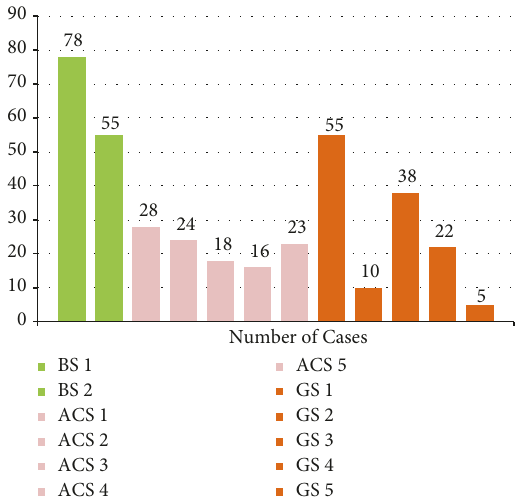
Figure 2: Comparison of case volume stratified by surgeon and surgery (n=2), acute care surgery (n=5), and general surgery